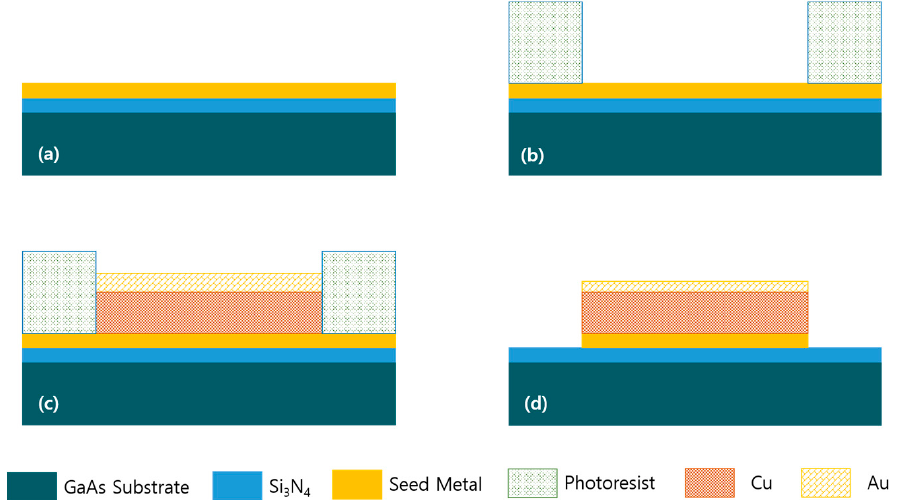
Figure 6. Schematics of the proposed BPF device fabrication. ( a ) Wafer passivation of 200 nm thick Si 3 N 4 deposited by PECVD and 100 nm thick gold seed metal deposited by sputtering. ( b ) Plating mask lithography and development. ( c ) Cu/Au (4.5 µm/ 0.5 µm) metallization by plating. ( d ) Removal of photoresist by lift-off and seed metal dry etching for chip isolation.